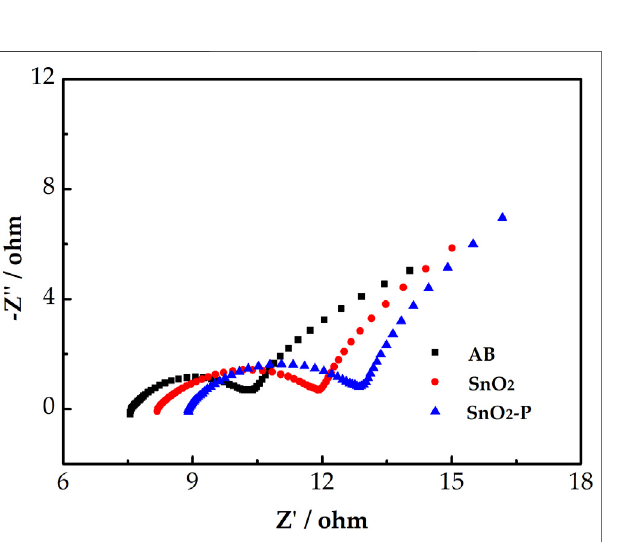
FIGURE5| CVcurvesofAB (A) ,SnO 2 (B) ,andSnO 2 -P (C) atscanratesfrom5to25 mV s − 1 carriedoutin1.6 M V 3+ +3.0 MH 2 SO 4 electrolyte.Plotsoftheredox peak current vs. the square root of the scan rate for the AB, SnO 2 , and SnO 2 -P electrodes (D) .